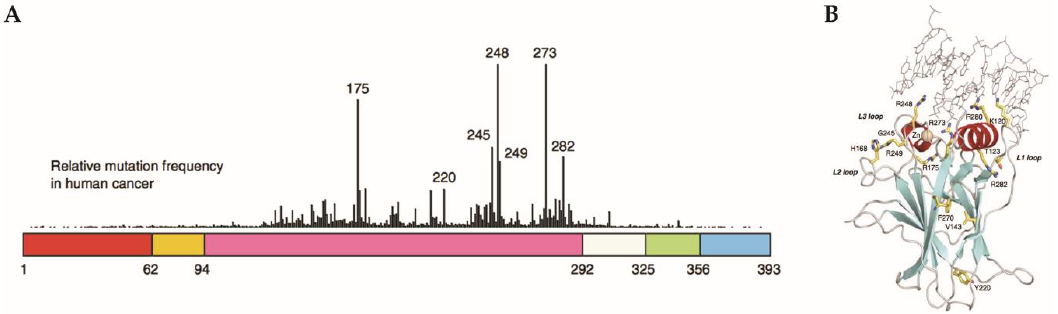
Figure 3. Most TP53 mutations are in the DNA binding domain. ( A ) The schematic view of the domains of p53 protein. The protein has 393 residues with numerous different domains including the N-terminus ( red ), proline rich domain ( orange ), DNA binding domain ( purple ), tetramerization domain ( green ) and negative regulatory domain/C-terminus ( blue ). The peaks represent the frequency of mutations in cancer with the DNA binding domain containing the six hot spot mutations. ( B ) Ribbon diagram of DNA-bound p53 (PBD ID 2AHI). The residues highlighted in yellow represent residues that are hot spot mutations as well as other residues of interest. Modified and reprinted with permission from Springer Nature: [Springer Nature] [Oncogene] [112].